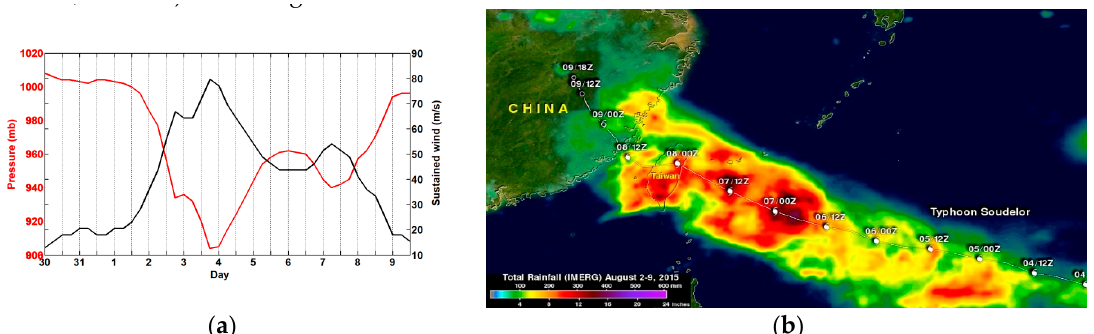
Figure 2. ( a ) Time evolution of minimum central pressure (black) and 1 min sustained wind (red) of TC Soudelor from 30 July 2015 00:00 UTC to 9 August 2015 12:00 UTC, derived from best track observations. ( b ) Estimated total rainfall from 4 August 06:00 UTC to 9 August 18:00 UTC, derived from Global Precipitation Measurement (produced by H. F. Pierce from SSAI / NASA / JAXA ).